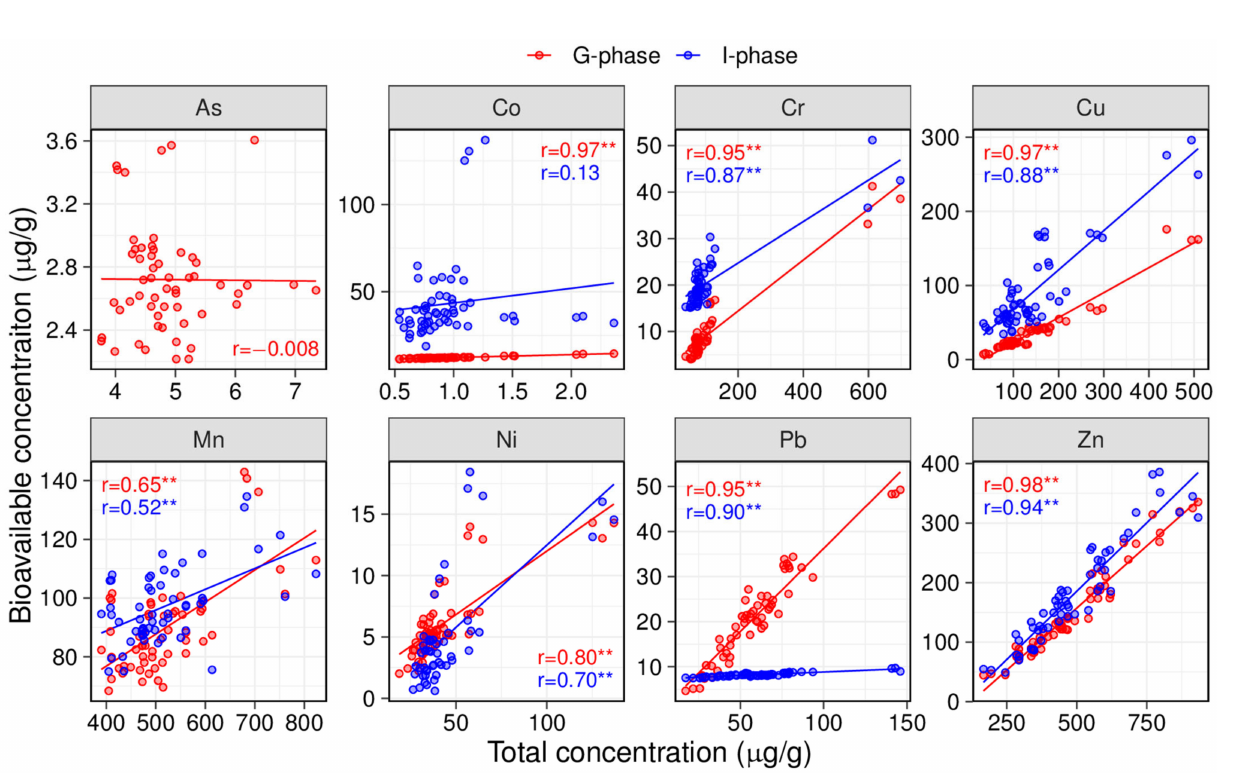
Figure 2. Scatter plot correlation for total concentration ( µ g/g) versus bioaccessible concentrations ( µ g/g) of toxic metals of roadside dust in Dhaka city. Double asterisk (**) designates statistically significant at p =